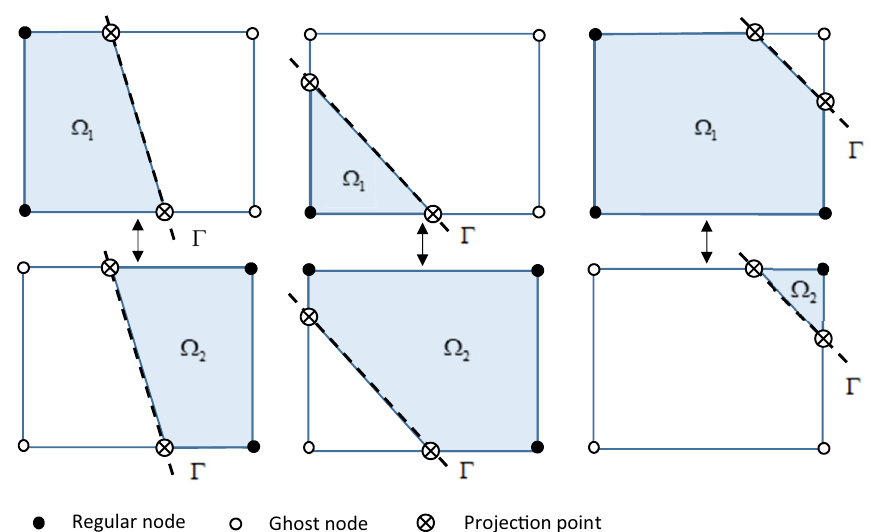
Regular node Ghost node Projec(cid:31)on point Fig. 5 A Q4 element crossed by an interface, showing the three possible cases, where the arrows indicate coupled overlapping